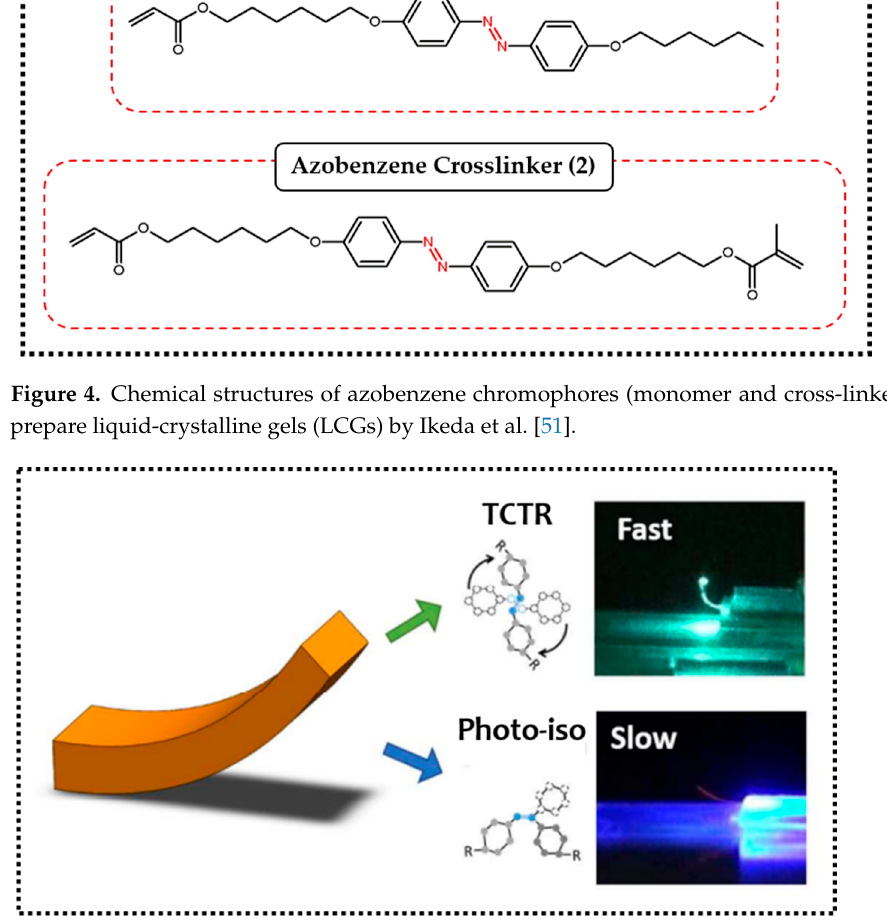
Figure 5. Sketch and bending snapshots of azobenzene-doped liquid-crystal polymer (azo-LCP) at 445 nm ( Fast-Top ) and 365 nm ( Slow-Bottom ), respectively, representing trans-cis-trans reorientation (TCTR) and photoisomerization mechanisms. Adapted with permission from Reference [52], ACS, 2018.